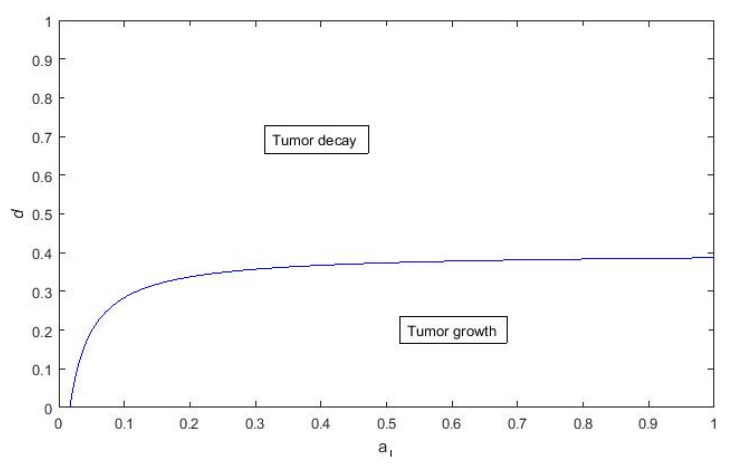
Figure 3. Stability map around the tumour-free equilibrium point, E 0 when τ =